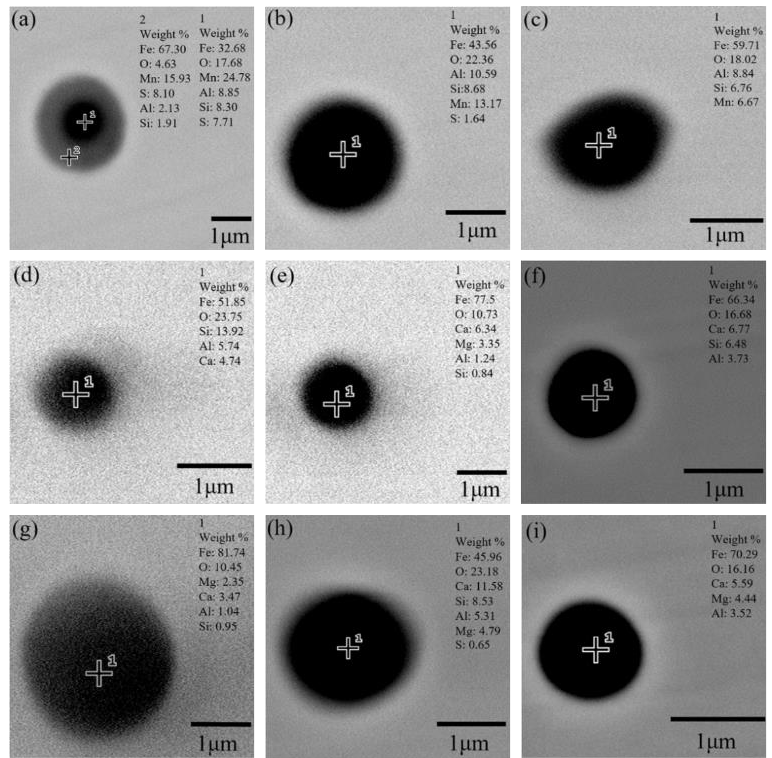
Figure 6. Morphology and size of typical inclusions in scheme B. ( a ) B-S1; ( b ) B-S1; ( c ) B-S1; ( d ) B-S2; ( e ) B-S2; ( f ) B-S3; ( g ) B-S3; ( h ) B-S4; ( i ) B-S4.